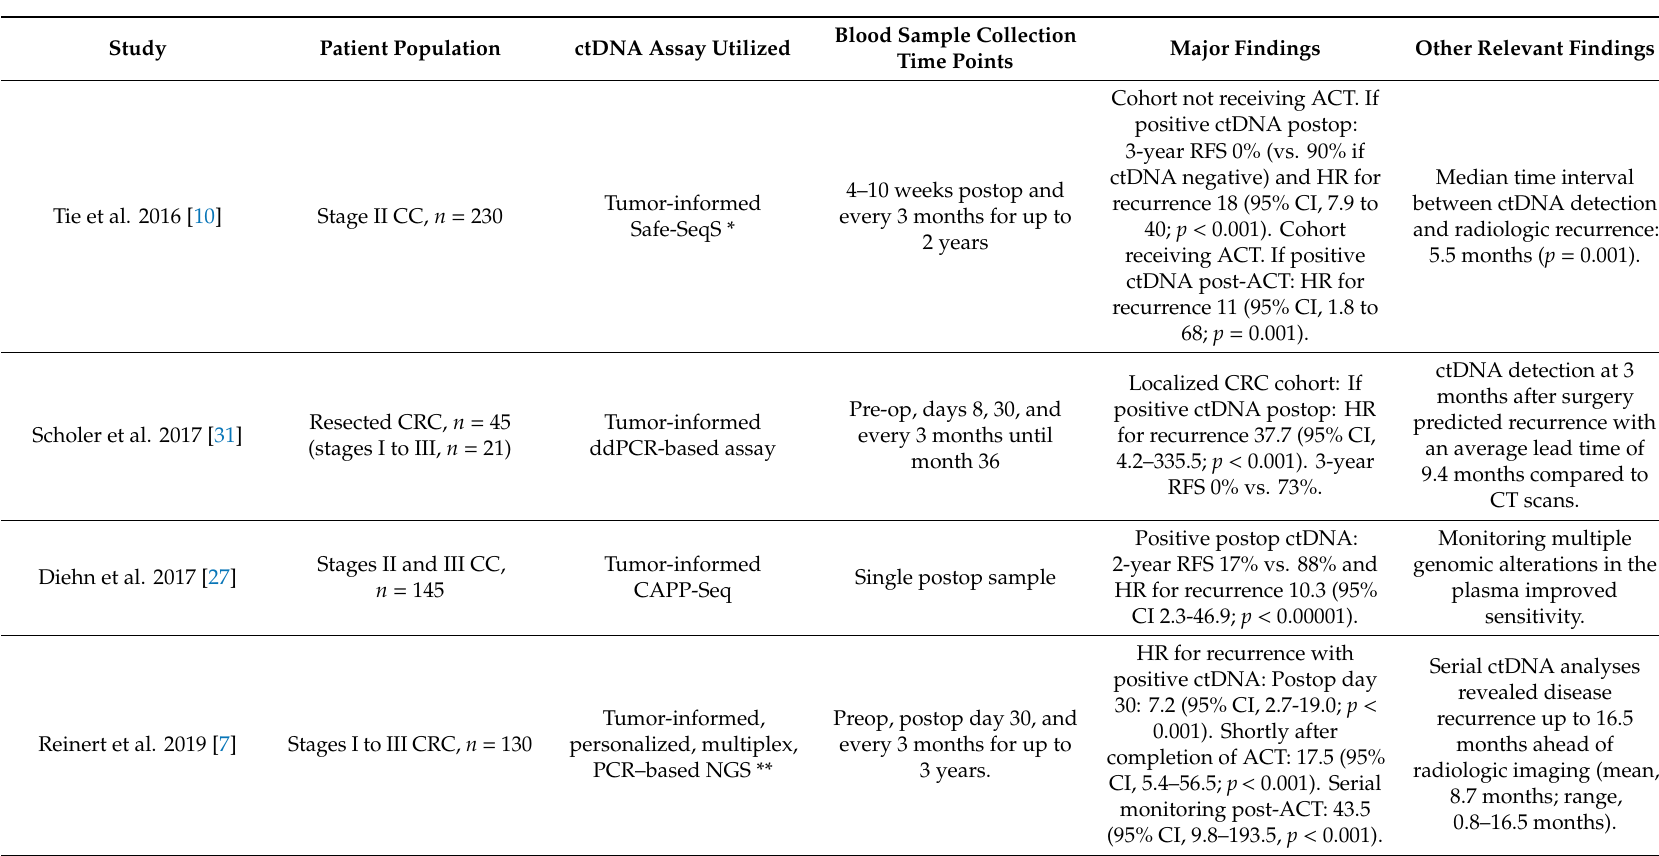
Table 1. Major studies supporting the clinical utility of ctDNA for minimal residual disease detection and post-therapy tumor surveillance in patients with resected early-stage colon